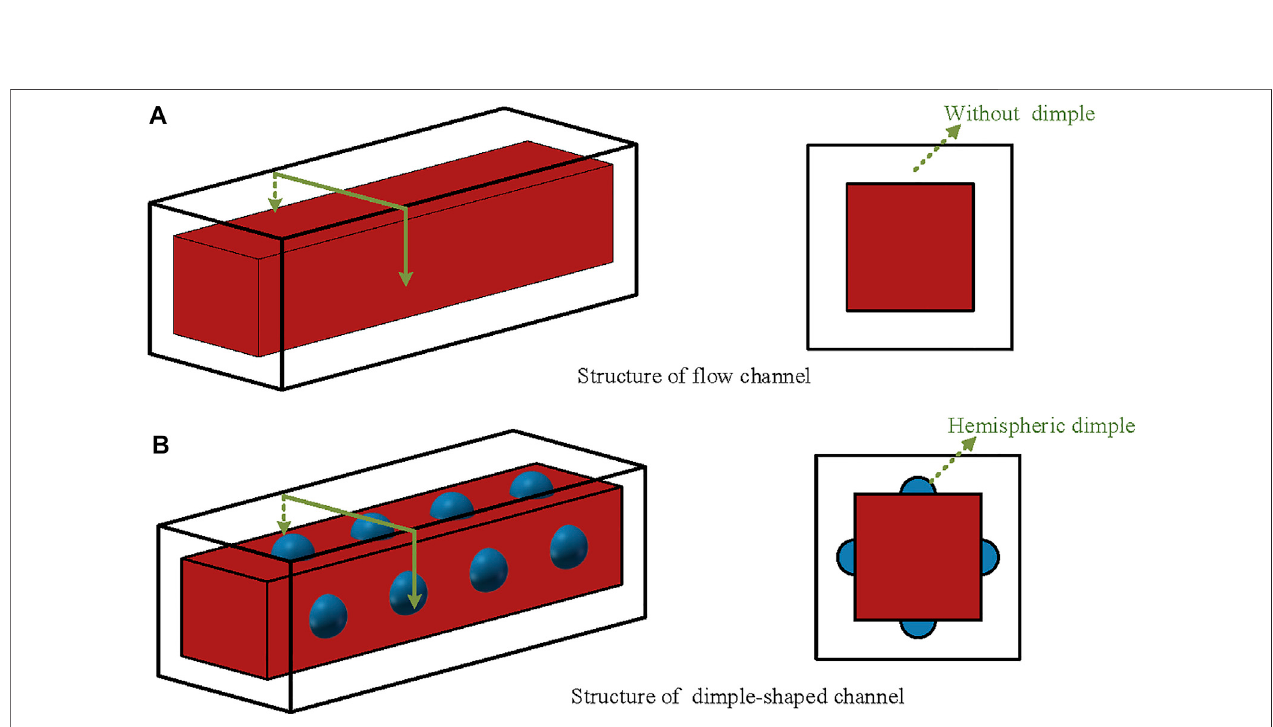
FIGURE 15 | Structure of dimple-shaped fl ow channels. (A) Structure of the fl ow channel. (B) Structure of the dimple-shaped channel.